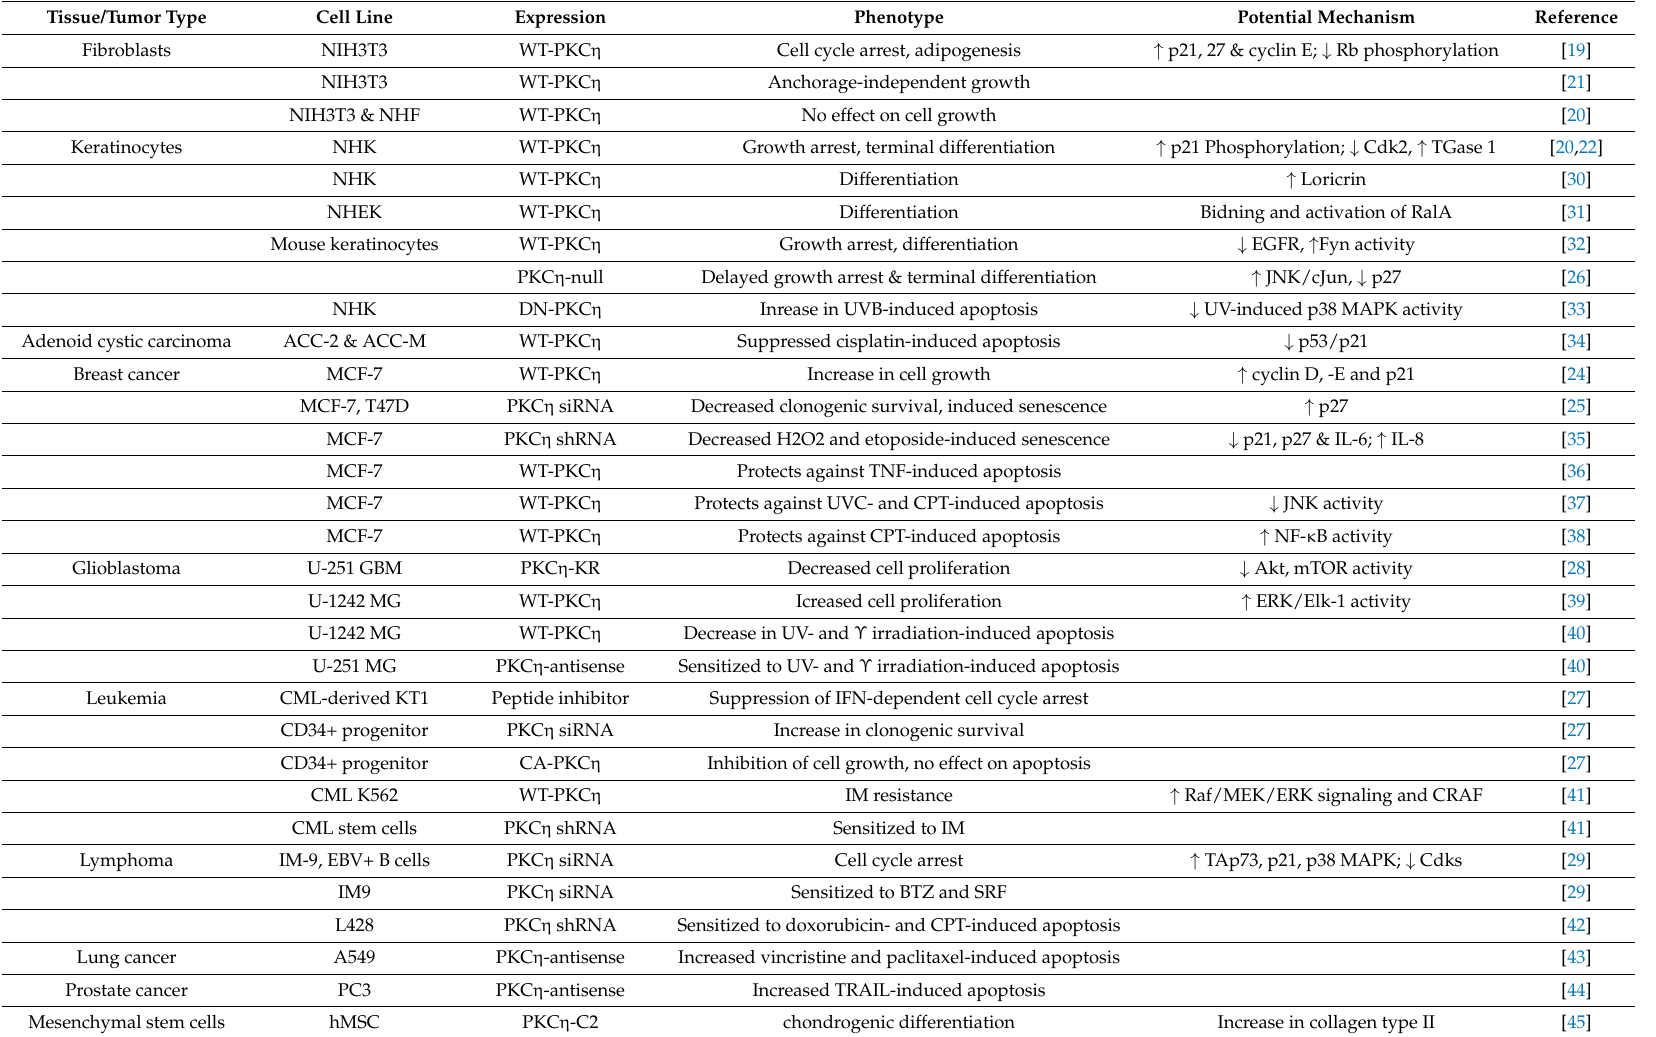
Table 1. Function of PKC η in different cell/tumor